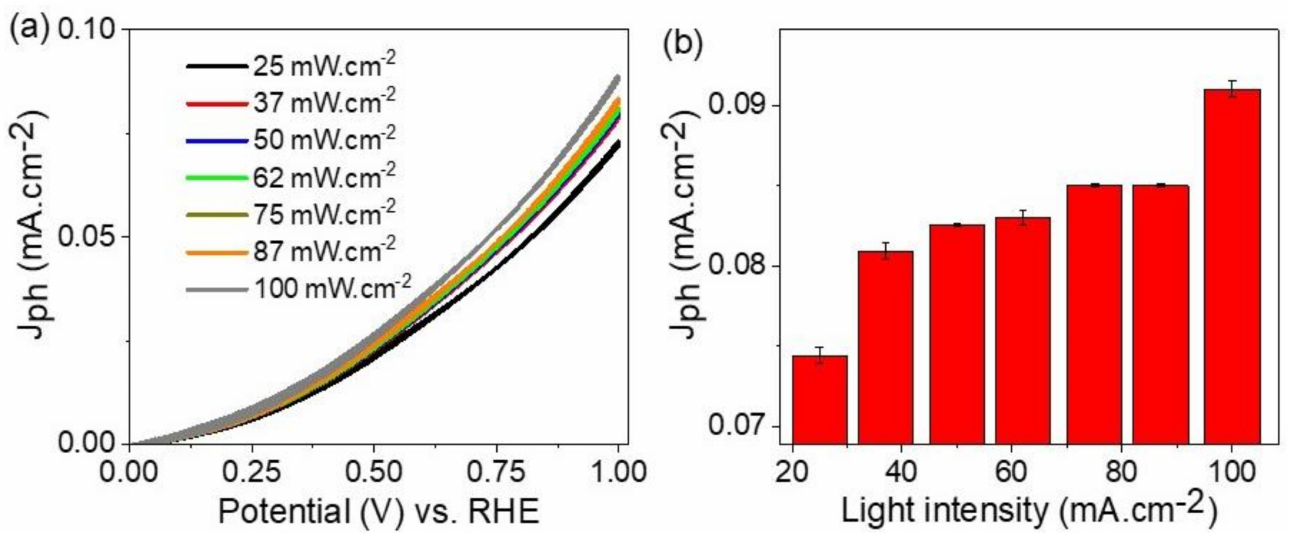
Figure 5. ( a,b ) The response of ATO/PANI/PbI 2 photoelectrode for the various light intensities, using J ph —potential